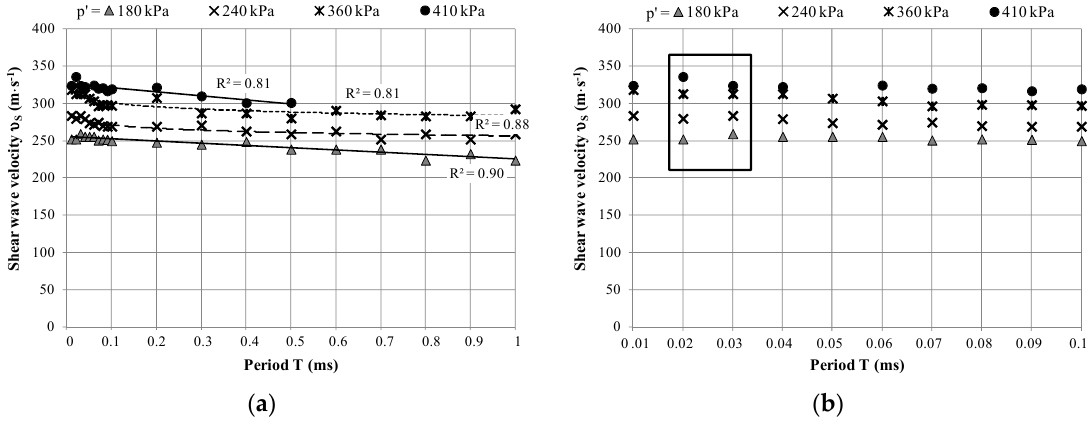
Figure 9. Variation of measured υ S with period: start-to-start method. ( a ) Period’s range from 0 to 1 ms; ( b ) Period’s range from 0.01 to 0.1 ms.